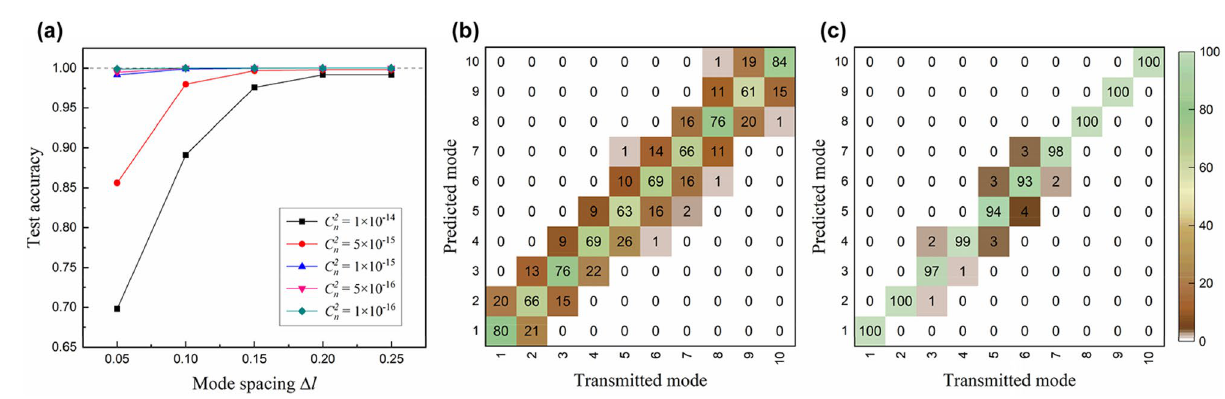
Figure 6. Influence of OAM mode interval (cid:31) l and turbulence strength C Recognition accuracy as a function of OAM mode spacing and ( b , c ) crosstalk matrices for a 1000-m link with 1 × 10 − 14 m − 2 / 3 . Here, ( b ) and (c) correspond to the results of (cid:31) l = 0.05 (10 OAM modes from 1.10 to C 2 n = 1.55) and (cid:31) l = 0.15 (10 OAM modes from 1.10 to 2.45), respectively. All data presented in ( a ) correspond to the mean values of 5 test results per data